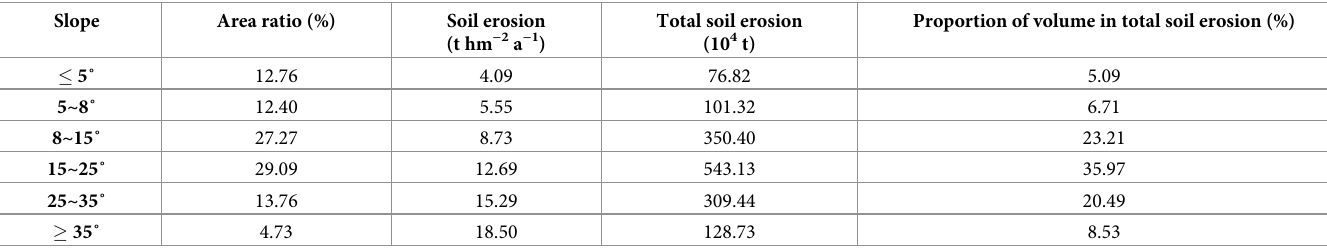
Table 6. Soil erosion intensity under different